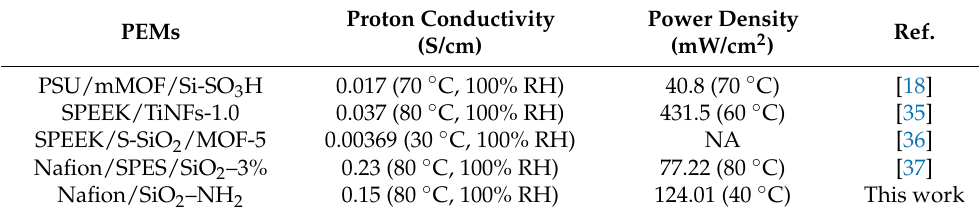
Table 2. Comparison of proton conductivity and power density with other reported